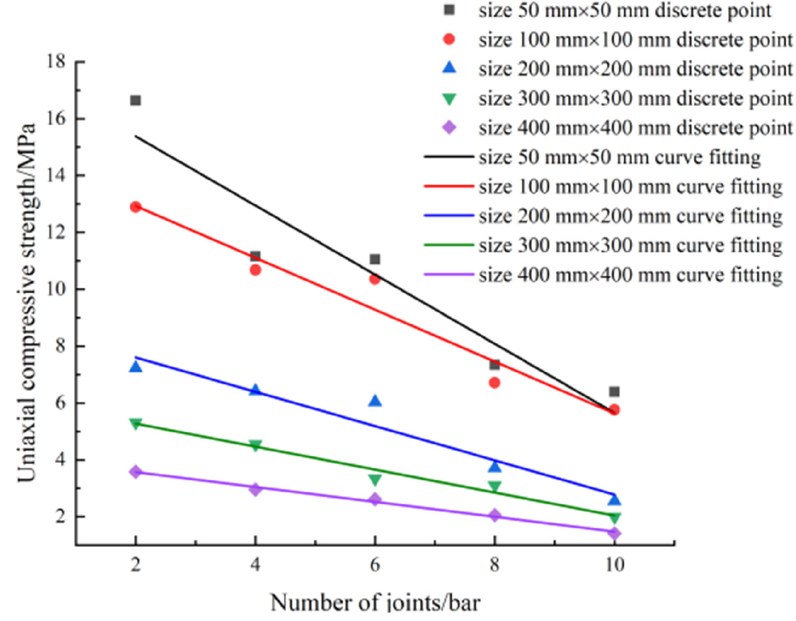
Figure 5. Fitting curves of UCS with different NPJs. Table 6. Fitting relationship between rock UCS and the number of joints. Rock Size